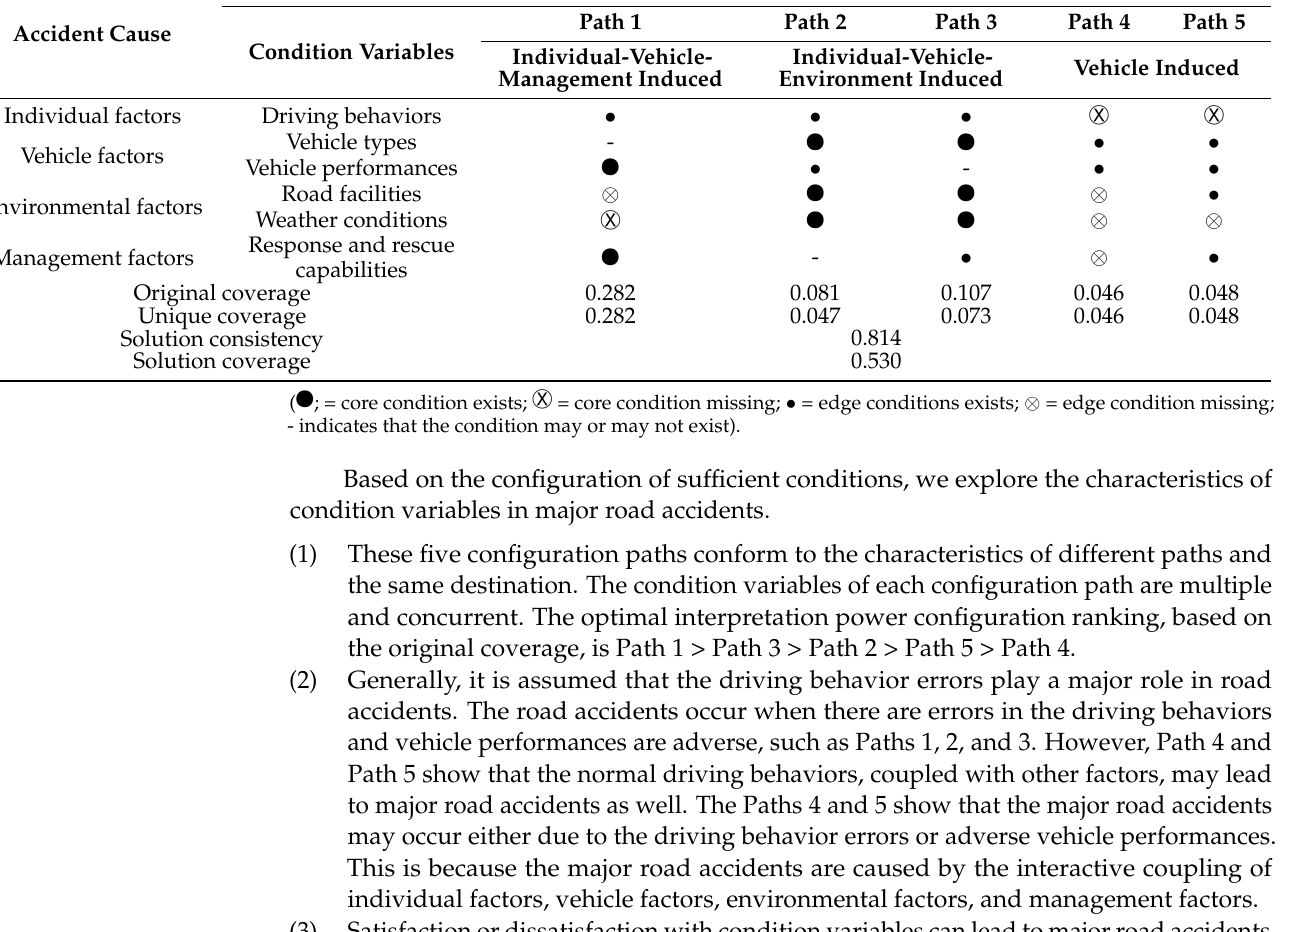
Table 3. The realization of the configuration of major road accidents by using fsQCA.